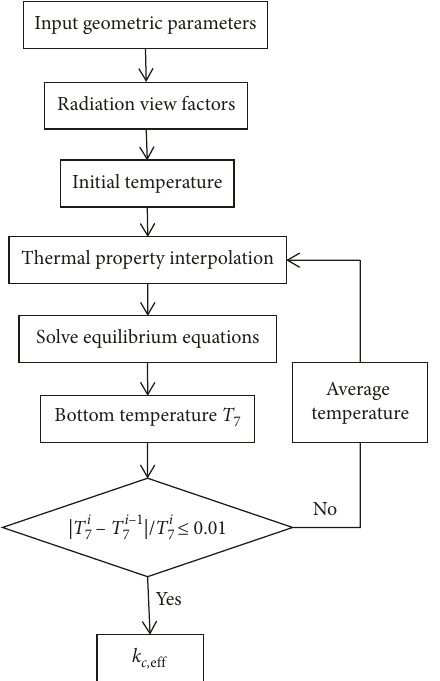
Figure 3: Flow diagram for calculating effective thermal